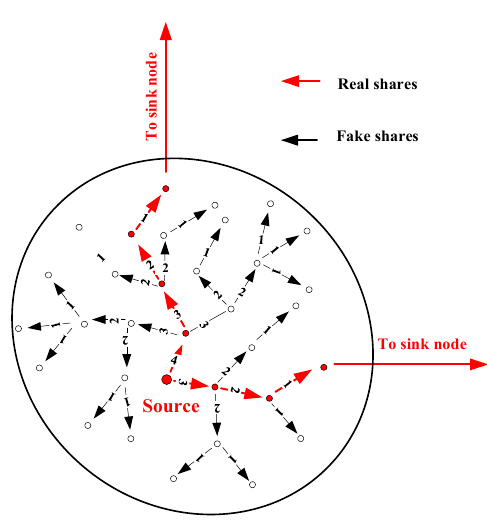
Figure 5. An example of cloud with two real shares.